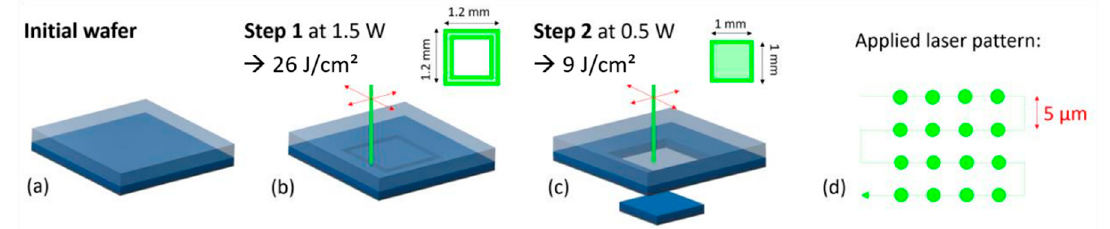
Figure 2. Sketch of the two-step laser lift-off process. ( a ) Initial GaN LED wafer with sapphire on top side, ( b ) selection of a free-standing LED chip area by removing an outer frame at high laser power, ( c ) lift-off of inner LED chip with less laser power, ( d ) applied scanning pattern, where each green dot marks the position of an impinging laser pulse.